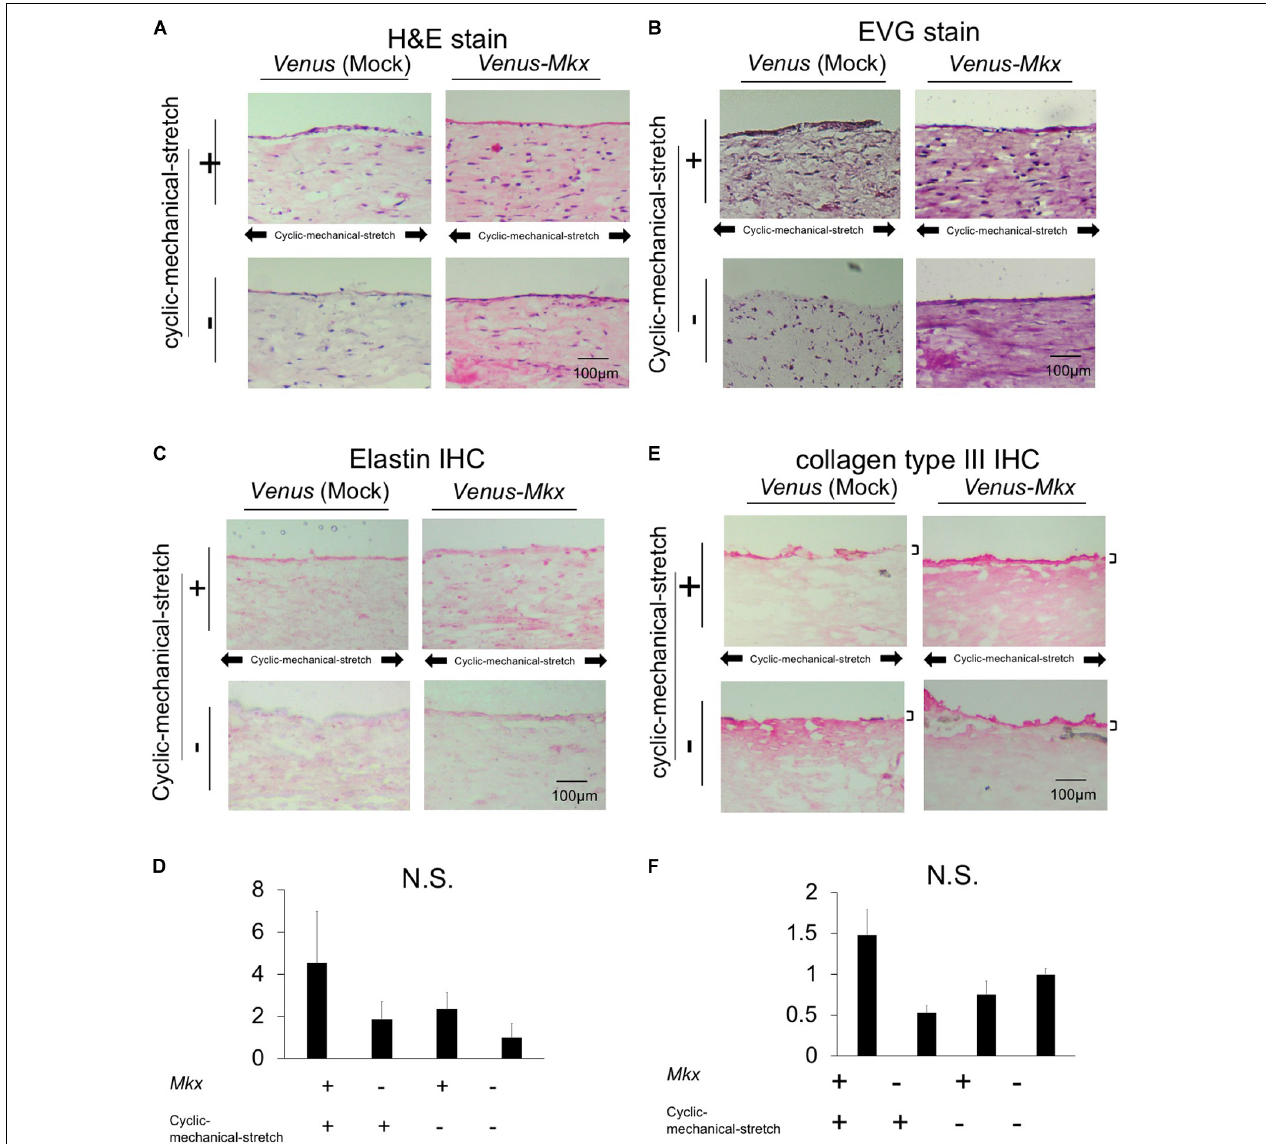
FIGURE 3 | Histological and immunohistochemical analysis of the tendon/ligament-like tissue. Histological (A,B) and immunohistochemical (IHC) (C,D) analyses. These tissues were generated under four different culture conditions: VMS+ (right top), VMS– (right bottom), VS+ (left top), and VS– (left bottom) ( n = 3). The direction of the cyclic mechanical stretch load is represented by black arrows. Scale bar: 100 µ m. (A) Representative micrographs of hematoxylin and eosin (H&E)-stained tissue sections. (B) Representative micrographs of Elastica Van Gieson (EVG)-stained tissue sections. (C) Representative micrographs of immunohistochemical staining for elastin in each tissue section. (D) Relative quantitative data of panel (C) . (E) Immunohistochemical analysis of the sectioned tendon/ligament-like tissue. Representative micrographs of immunohistochemical stain of collagen type III in each tissue section. Black bars depict collagen type III staining of the surface layer of the tendon/ligament-like tissue obtained from VMS + condition ( n = 3). Scale bar: 100 µ m. (F) Relative quantitative data of panel (E)